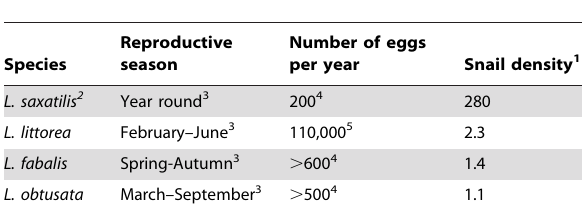
Table 1. Life-history traits in four species of Littorina .